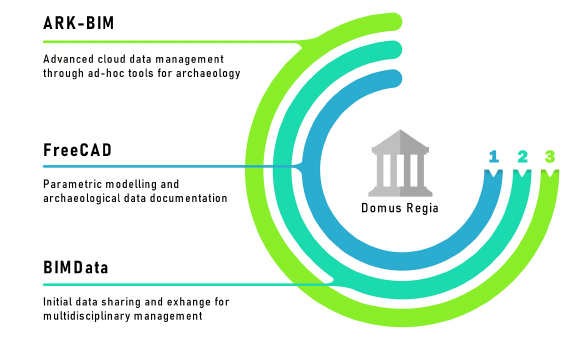
Figure 14 . Data documentation and management via open source HBIM solutions occurred for the Domus